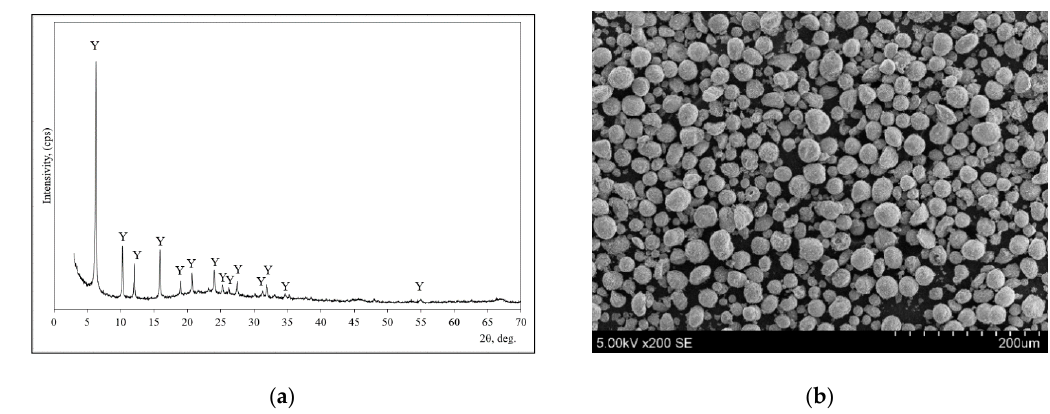
Figure 1. X-ray diffraction pattern of zeolitic by-product with ammonium chloride ( a ) and SEM micrographs ( b ), where Y is faujasite (73-2312) H 7.7 Al 42.56 · Si 139 · O 345.6 · zeolite